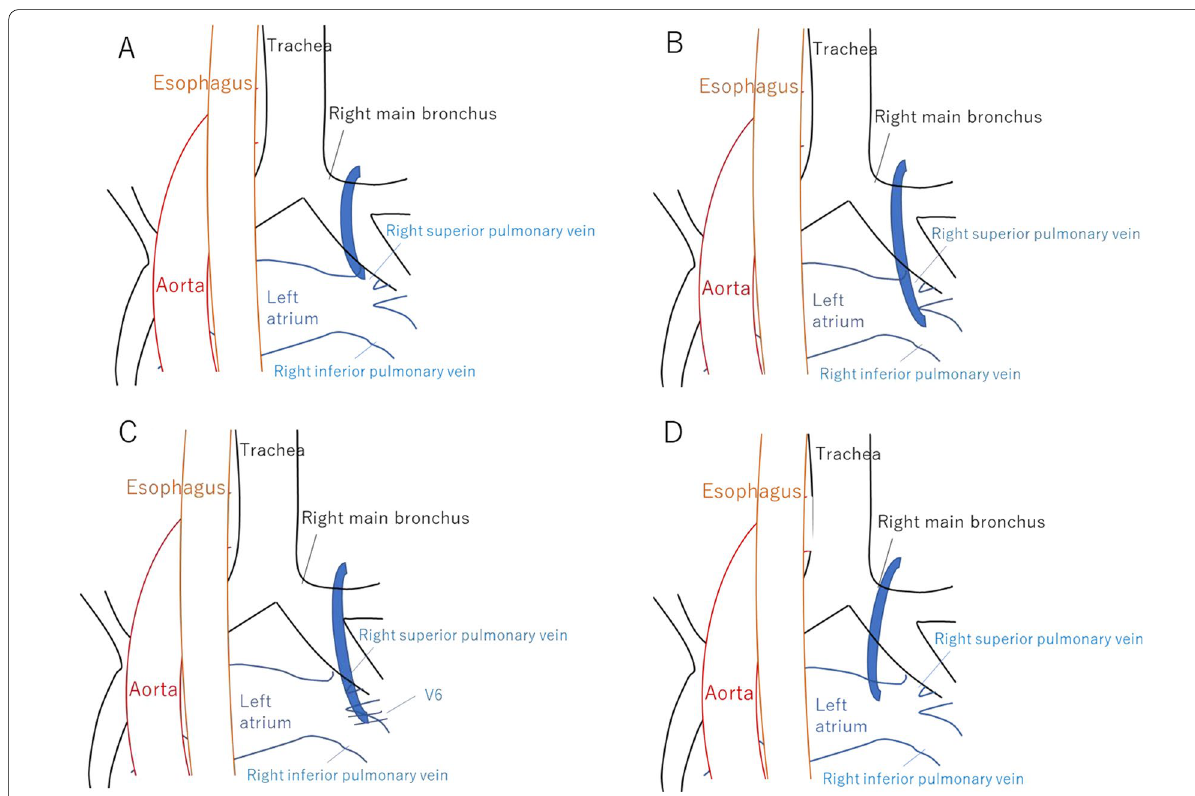
Fig. 4 The variation of the inflow site of the pulmonary vein. A The cases of the superior pulmonary vein flowing into the right superior pulmonary vein. B The cases of the inferior pulmonary vein. C The cases in which the right inferior pulmonary vein formed an independent branch of V6. D The cases of direct flow into the left